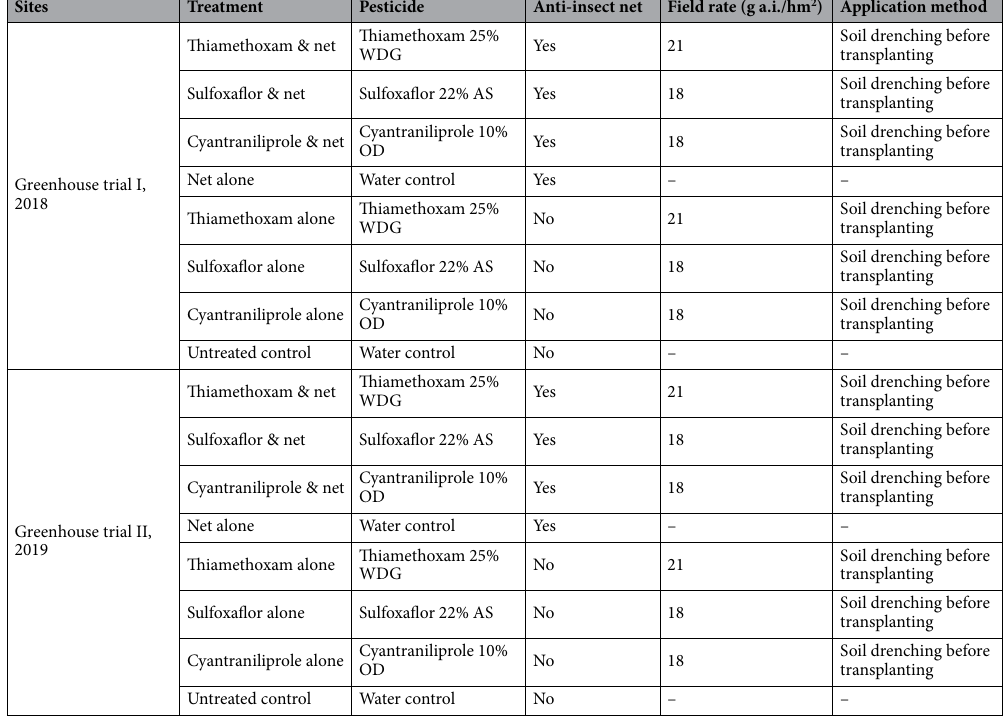
Table 6. Experimental greenhouse trial